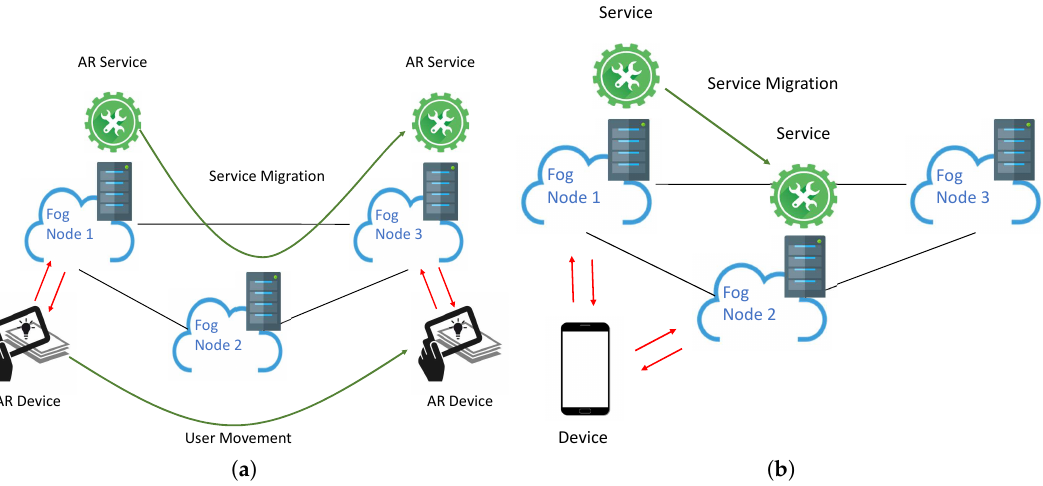
Figure 1. Container migration use cases: ( a ) mobility support; ( b ) platform